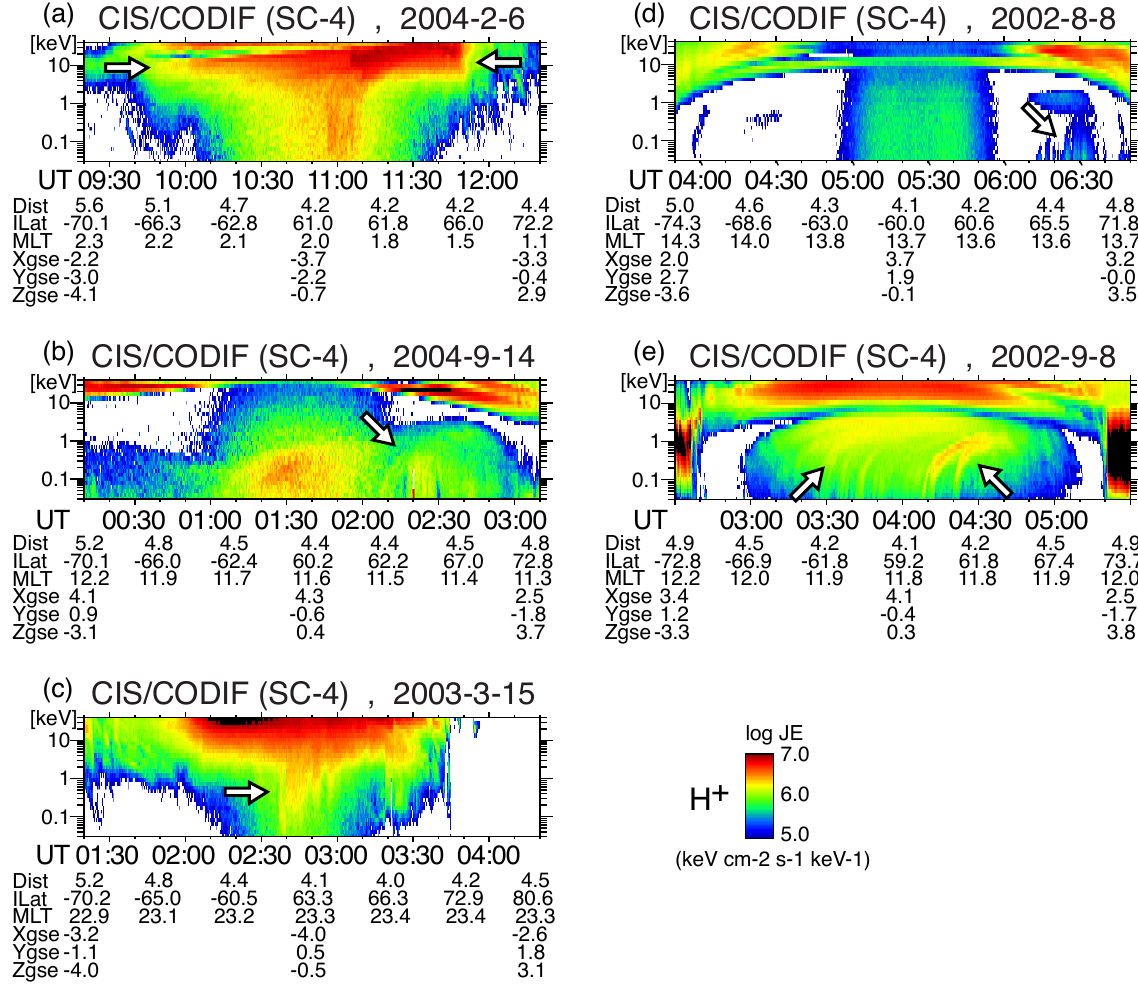
Fig. 2. Energy–time spectrograms of differential energy flux (keVcm − 2 s − 1 str − 1 keV − 1 ) of protons observed by CIS/CODIF on board Cluster SC-4 during perigee traversal on (a) 6 February 2004 (plasma sheet-like banded ions), (b) 14 September 2004 (wedge-like dispersed ions), (c) 5 March 2003 (vertical stripes), (d) 8 August 2002 (short burst of low-energy ions), and (e) 8 September 2002 (internal dispersive stripes). The object ion signature is marked by the empty arrow in each